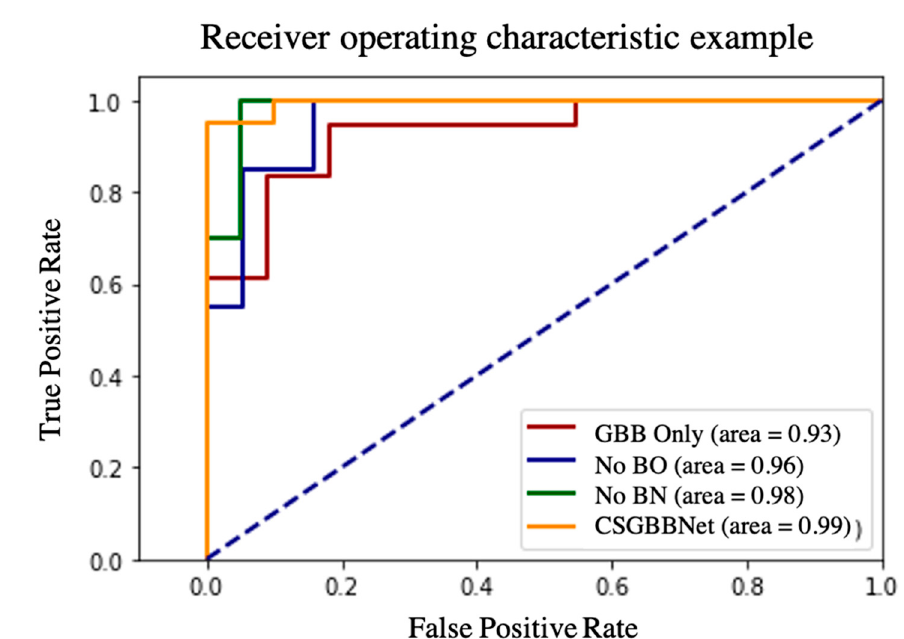
Figure 14. The ROC analysis curve results of our ablation study.